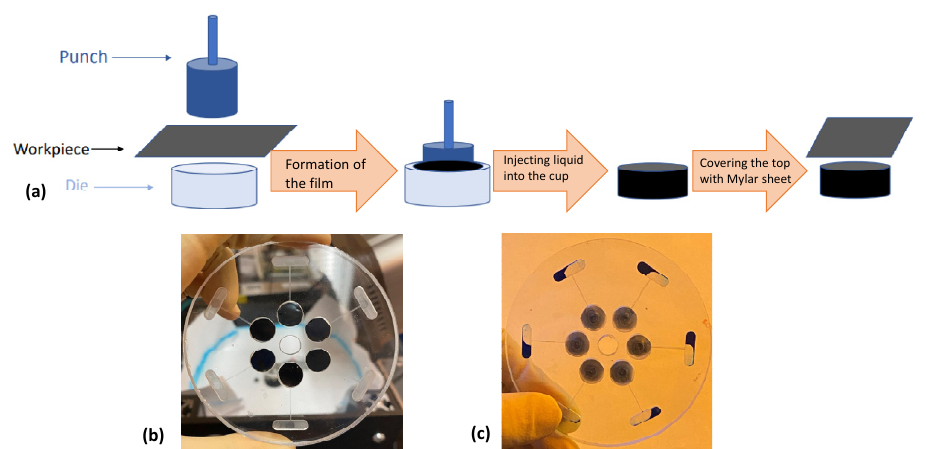
Figure 9. ( a ) LaserPack [44] fabrication using thermoforming of the mylar film. ( b ) Fully fabricated and assembled LaserPack containers on a CD before they dispense fluid. ( c ) Open LaserPacks with laser showing fluid dispensed on the CD.